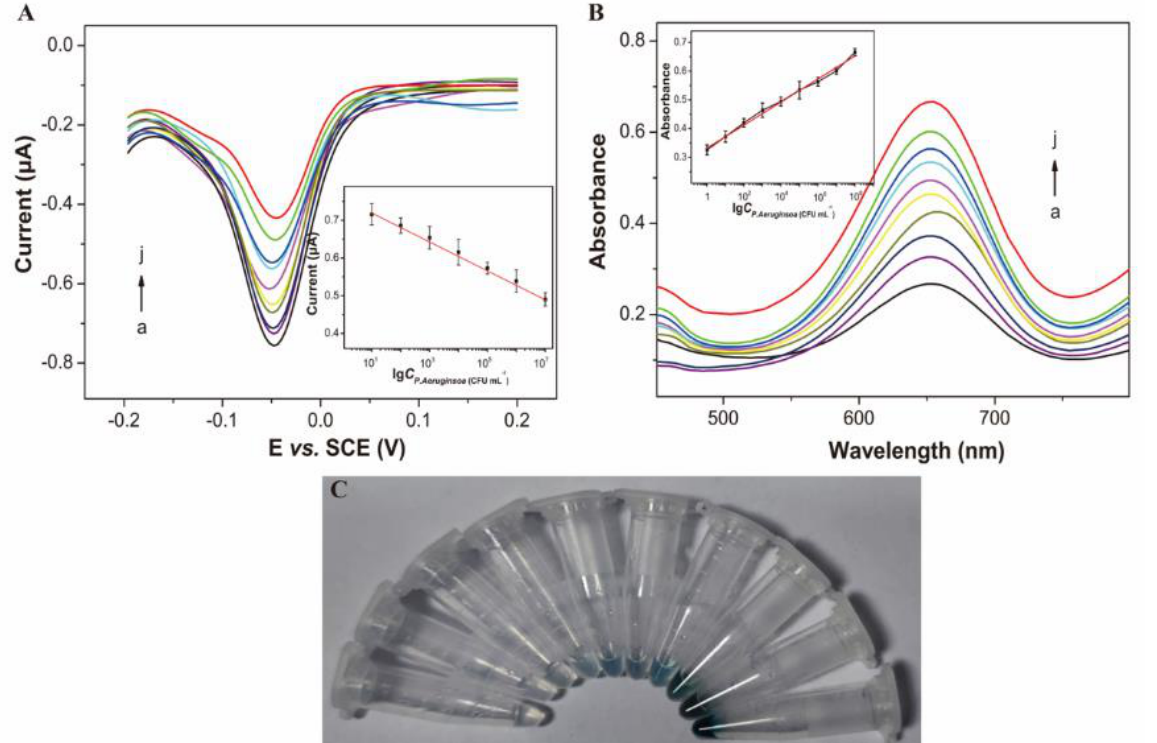
Figure 3. ( A ) Electrochemical sensor for detection of P. aeruginosa at different concentrations. ( B ) Colorimetric sensor for detection of P. aeruginosa at different concentrations. ( C ) Photograph of the colorimetric sensor in the presence of different P. aeruginosa concentrations. From a to j: 0, 1, 10 1 , 10 2 , 10 3 , 10 4 , 10 5 , 10 6 , 10 7 , and 10 8 CFU mL − 1 . The inset shows the linear relationship between the respective peak intensity and the patina concentration between 10 – 10 7 CFU·mL − 1 and 1 – 10 8 CFU·mL − 1 , respectively. The photo was collected after 8 min of reaction. Table 2. Comparison of sensitivity for P. aeruginosa detection.